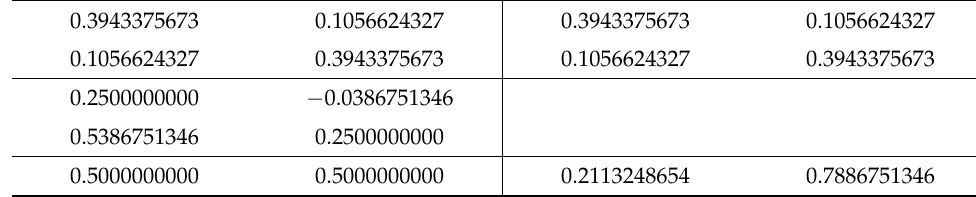
Table A10. G2|G2 method.